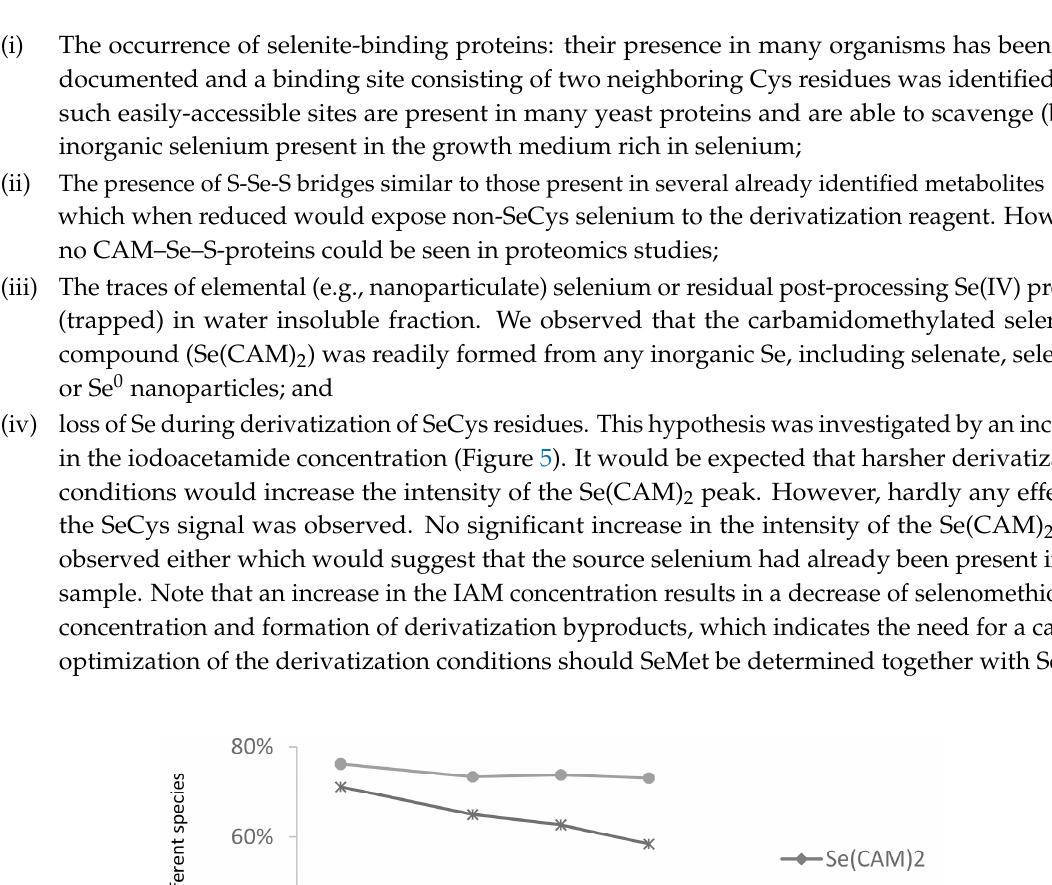
Table 2. Recoveries of selenocysteine (as selenium) added.